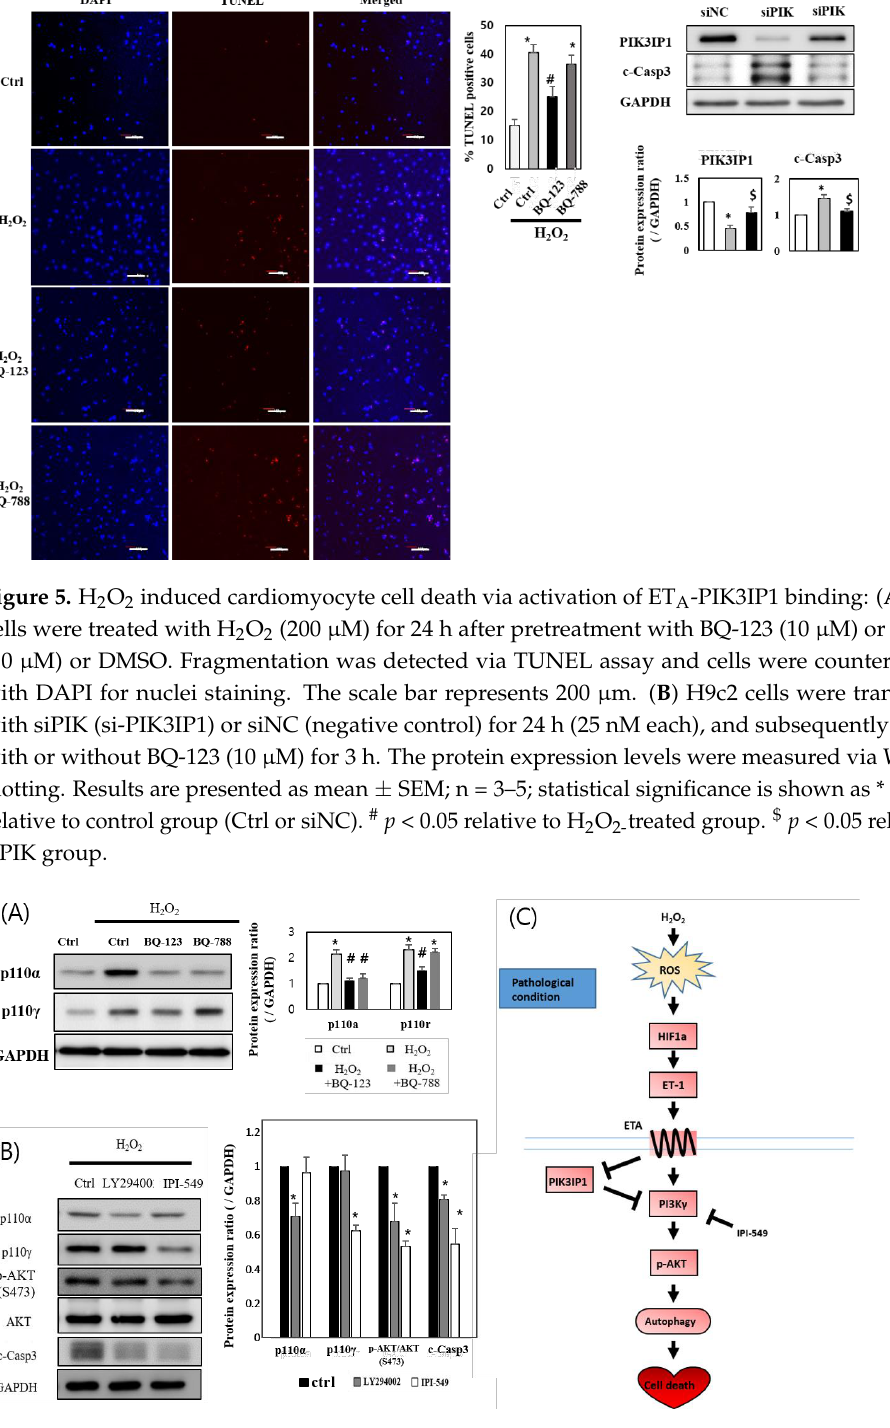
Figure 6. H 2 O 2 induces H9c2 cell death through the ET A -PIK3IP1- PI3Kγ axis. ( A ) H9c2 cells were treated with H 2 O 2 (200 μM) for 3 h after pretreatment with BQ-123 (10 μ M) or BQ-788 (10 μ M) or DMSO. The protein expression levels were measured via Western blotting. ( B ) Cells were treated with H 2 O 2 for 3 h after pretreatment with 20 μM LY294002 (LY) or 10 μM of IPI-549 (IPI). The ex- pression levels were measured via Western blotting. Results are presented as mean ± SEM; n = 3 – 5; statistical significance is shown as * p < 0.05 relative to control group. # p < 0.05 relative to H 2 O 2- treated group. ( C ) The proposed model shows that the anti-ischemic effects of PIK3IP1 in reducing the likelihood of cardiac cell death are mediated through its interactions with the ETA- PI3Kγ -AKT axis.